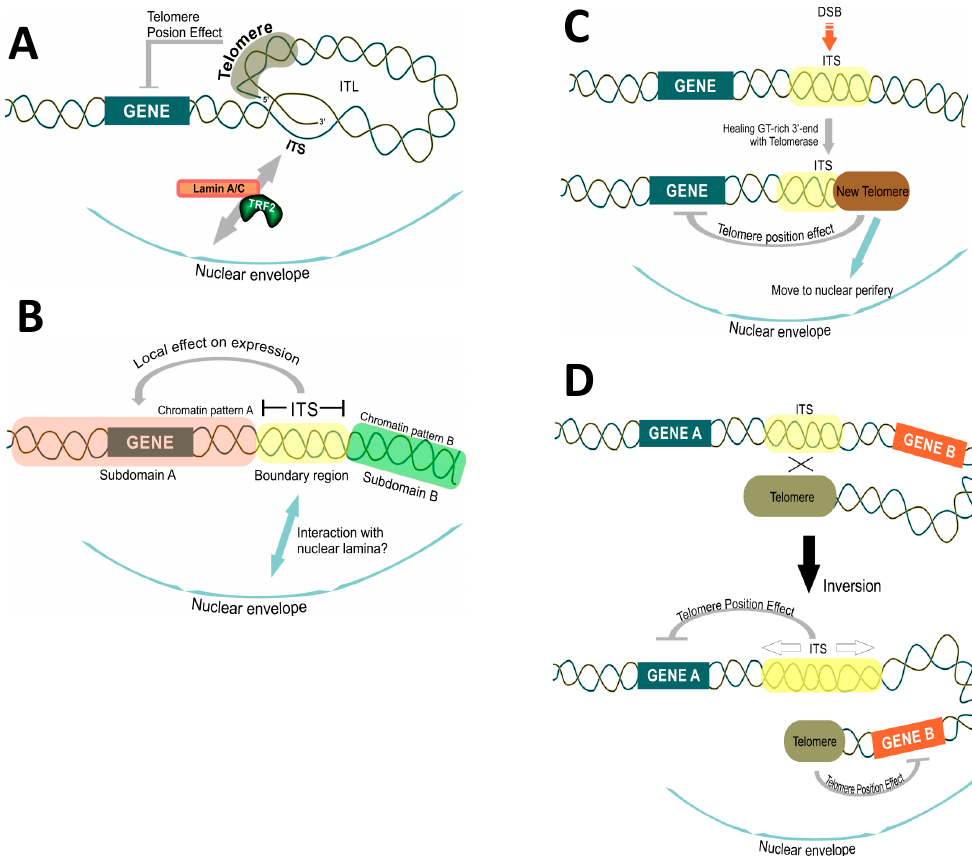
Figure 4. Possible roles of ITSs in the genome. (A) ITSs can participate in the formation of the Interstitial t-loop (ITL). This ITL can play an essential role in telomere maintenance and regulation of gene expression. Mediated by Lamin A/C and TRF2, the interaction of the ITS with the telomere can regulate the chromosome structure and position into the nucleus. Juxtaposion of the telomere and ITS may influence expression of genes near the ITS [267,297,326,329,330]. (B) ITSs can serve as boundary elements in the genome. Through recruitment of proteins that specifically bind to telomeric repeats and possess general regulatory activity, such as Rap1 in yeast [109] (yellow oval), ITSs can regulate the structure of adjacent chromatin and divide the chromosome into subdomains (orange and green rectangles). A possible interaction of ITSs with the nuclear lamina may regulate the 3D genome structure. (C) ITSs are potent elements conferring karyotype plasticity. ITSs can serve as spare sites for telomere formation and can impact the outcome of DSB repair [335] and can seed a new telomere. (D) Recombination between the ITS tract and the telomere can result in the inversion of the chromosome arm with a consequent effect on gene expression [299,336].